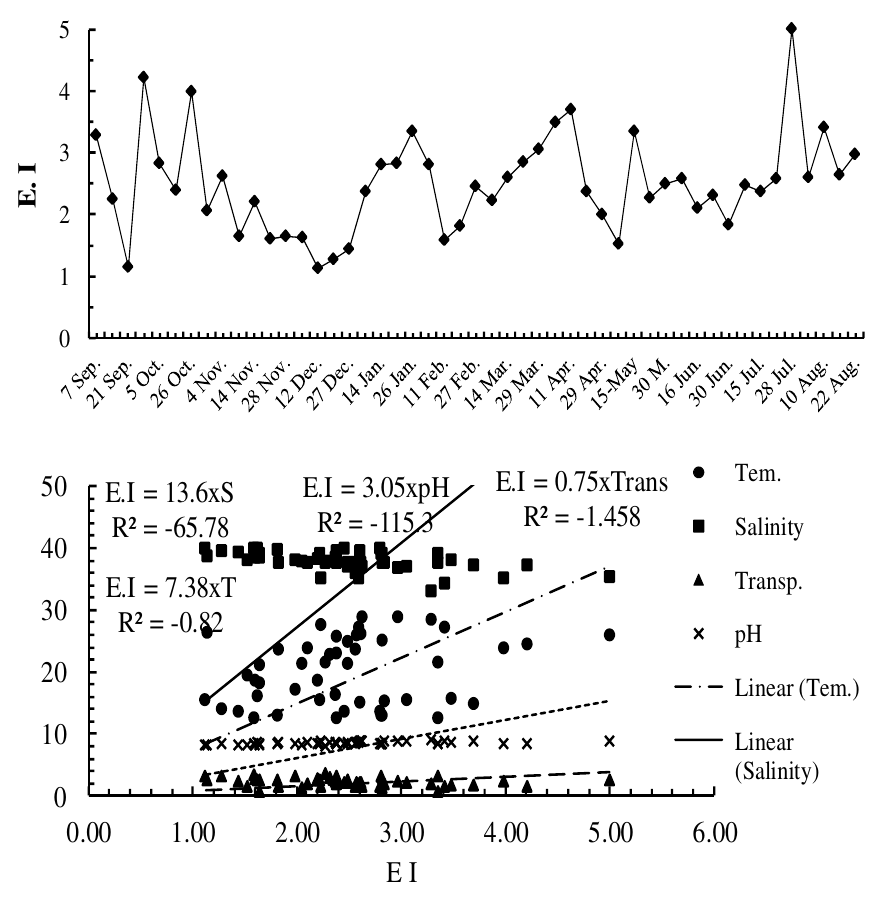
Fig. 2 Values of the Eutrophi- cation